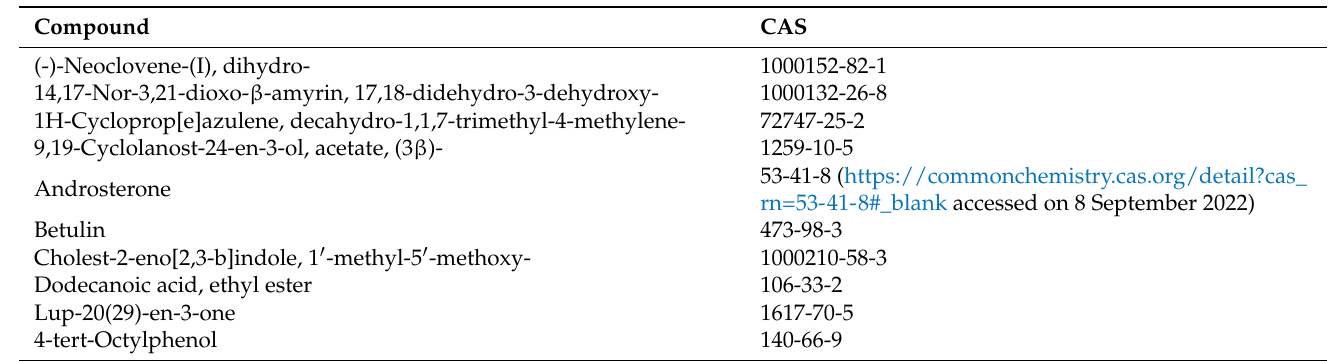
Table 1. Selected compounds identified in the low-temperature propolis extract that show biological activity towards androgen